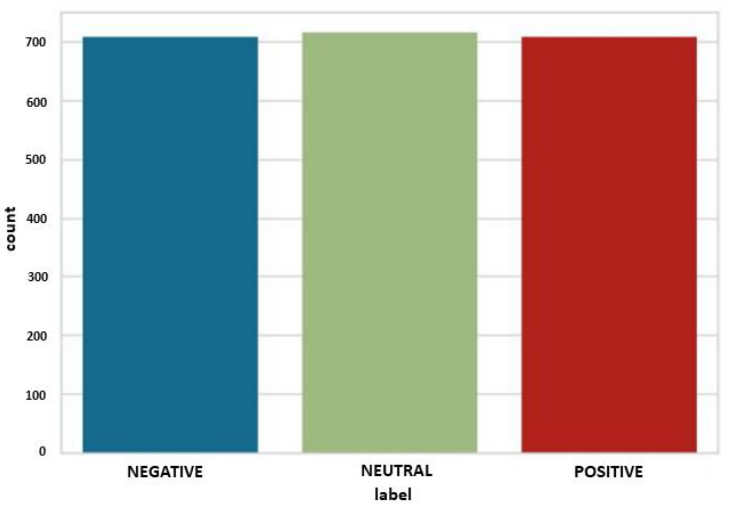
Figure 2. Visualization of three emotional